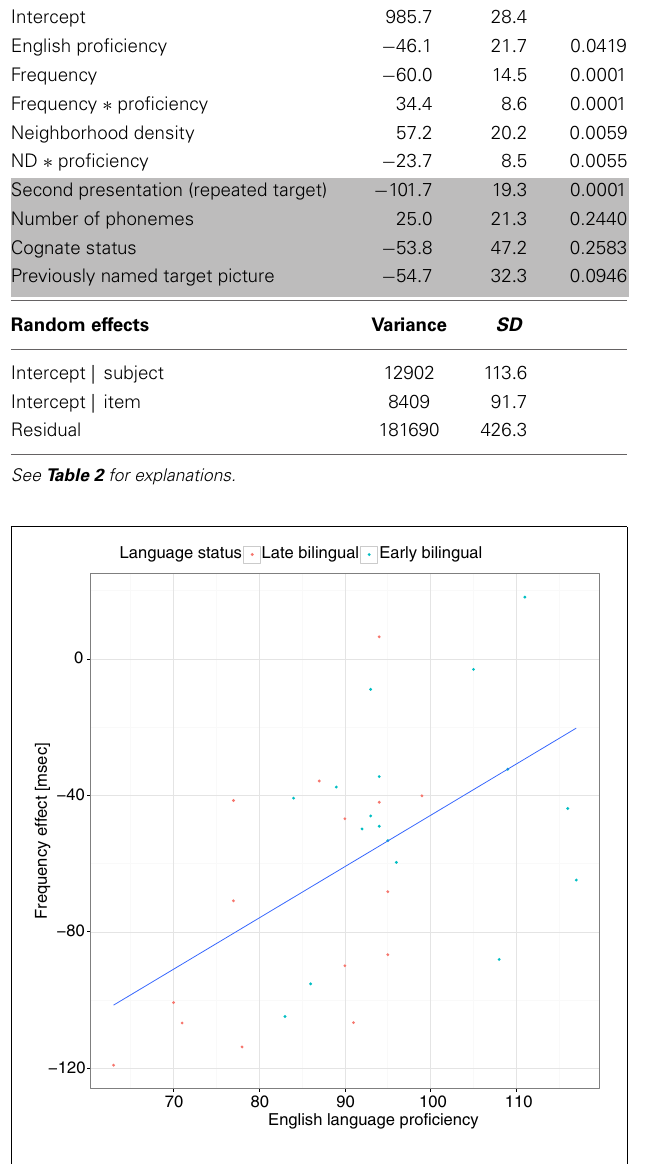
FIGURE 6 | Frequency effects as a function of language proficiency and language status. The y-axis shows the frequency effect for 1 SD change in log10 lexical frequency, extracted from the mixed-effect regression model run on the raw data of the bilingual participants (see text). Each dot represents one participant. The regression line shows the best fit.